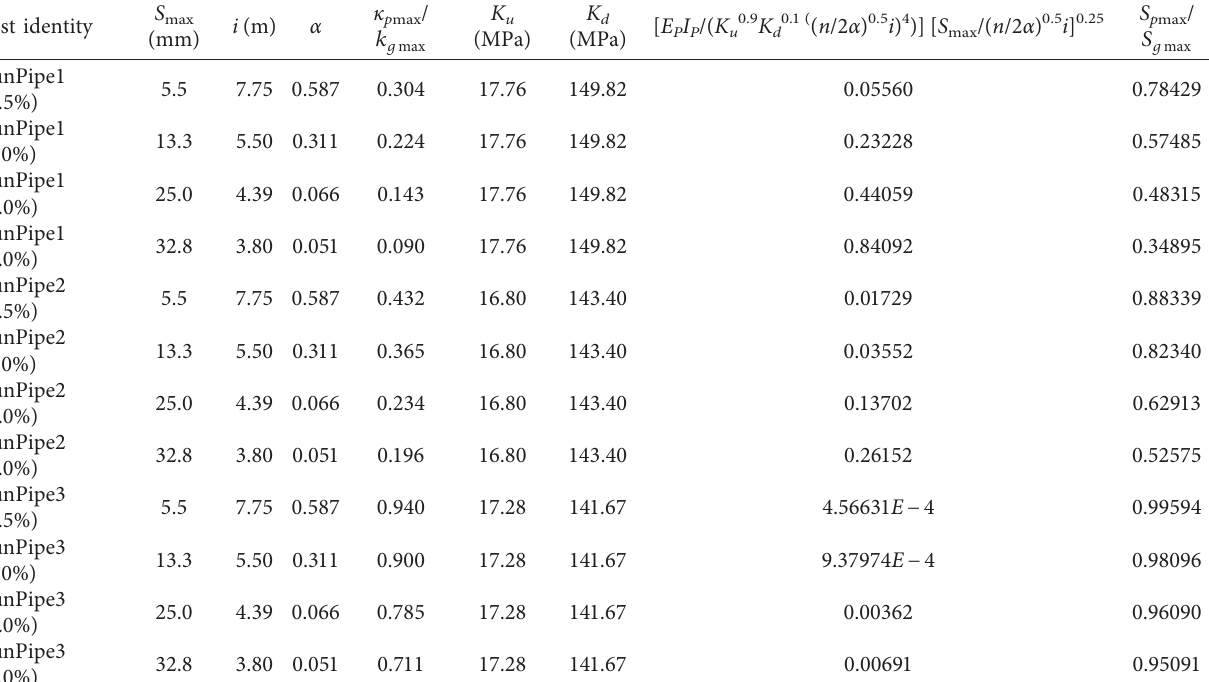
Table 6: Summary of the calculation parameters of the centrifuge model